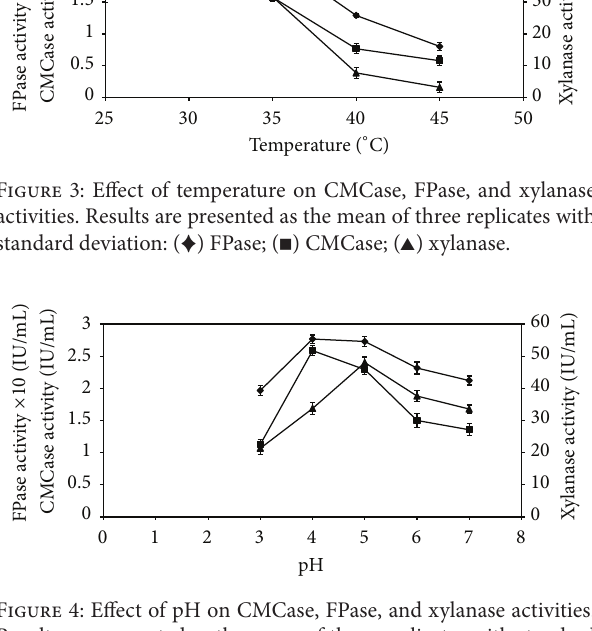
Figure 4: Effect of pH on CMCase, FPase, and xylanase activities. Results are presented as the mean of three replicates with standard deviation: ( Q ) FPase; ( ◼ ) CMCase; ( 󳵳 )